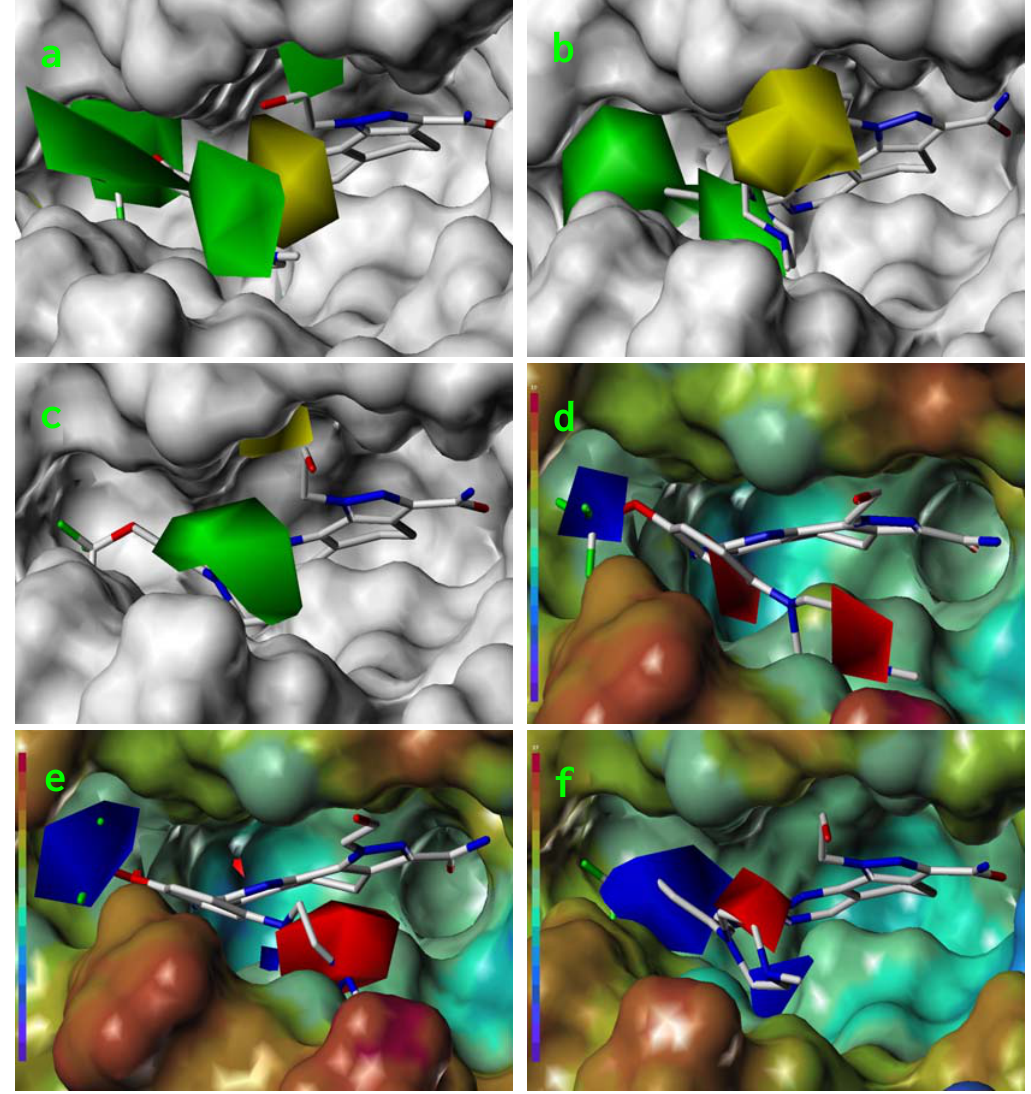
Figure 7. The CoMSIA contour map combined with compound 73 . Steric field distribution for ( a ) model 4, ( b ) model 5 and ( c ) model 6, on the background of protein surface. Electrostatic field distribution for ( d ) model 4, ( e ) model 5, and ( f ) model 6, on the background of electrostatic potential surface colored from purple to red owing to the increase of electron density. Hydrogen bond donor field distribution for ( g ) model 4, ( h ) model 5 and ( i ) model 6. Green contours indicate regions where bulky groups increase activity, whereas yellow contours indicate regions where bulky groups decrease activity. Positive potential favored areas are in blue, and positive potential unfavored areas are in red. Cyan and purple contours indicate favorable and unfavorable hydrogen bond donor group. The hydrogen bond is represented with orange dotted